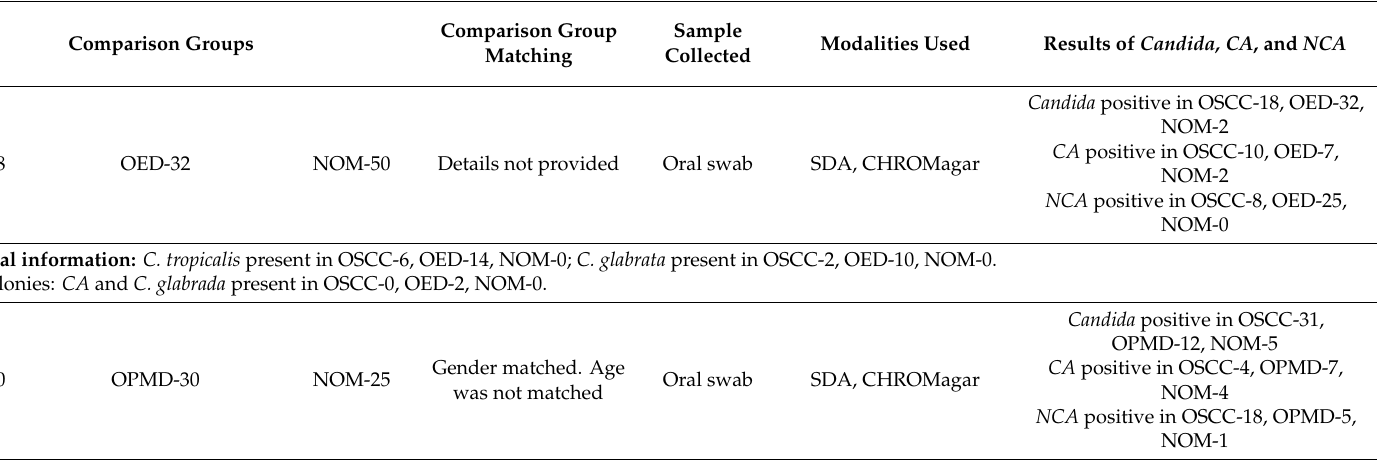
Table 1. Summary of the data extracted from the studies included in the systematic